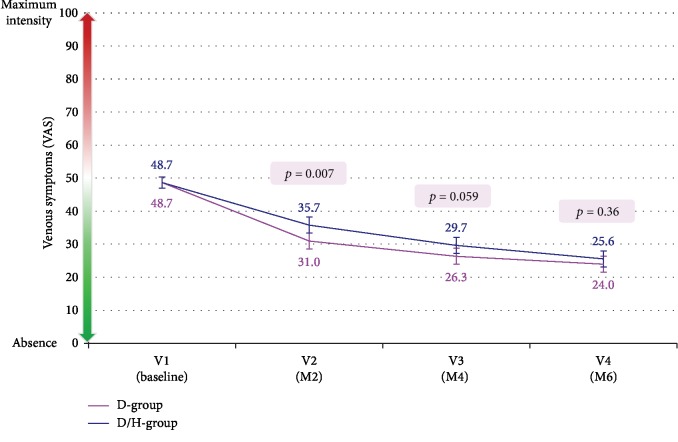
Time course of venous symptoms during the study assessed with a visual analog scale (results are given as adjusted means ± SE).